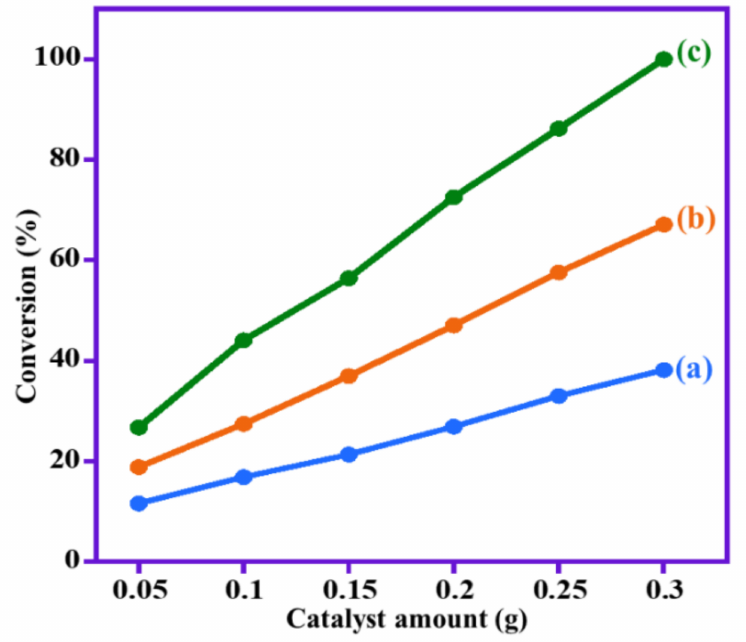
Figure 11. Influence of varying catalyst quantity on BOH oxidation in the presence of ( a ) MnCO 3 , ( b ) (1%) ZnO–MnCO 3 , and ( c ) (1%) ZnO–MnCO 3 /(1%-NDG)